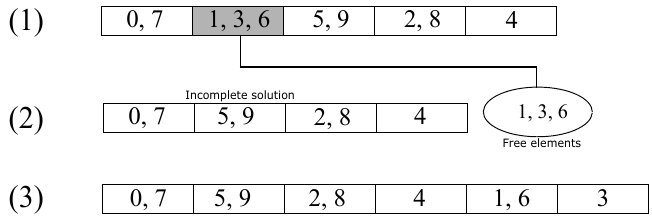
Figure 3. Elimination